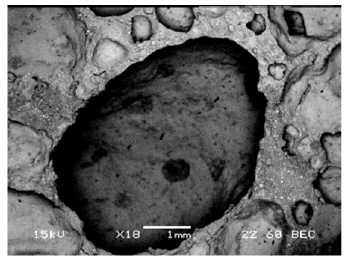
Figure 6. Scanning electron microscopy images of GeoFoam at magnification ×18 and scale 1 mm (S/L: 3.5 g/mL, [KOH]: 8 M, Al powder addition: 15 wt.%, curing: 48 h at 70 °C).